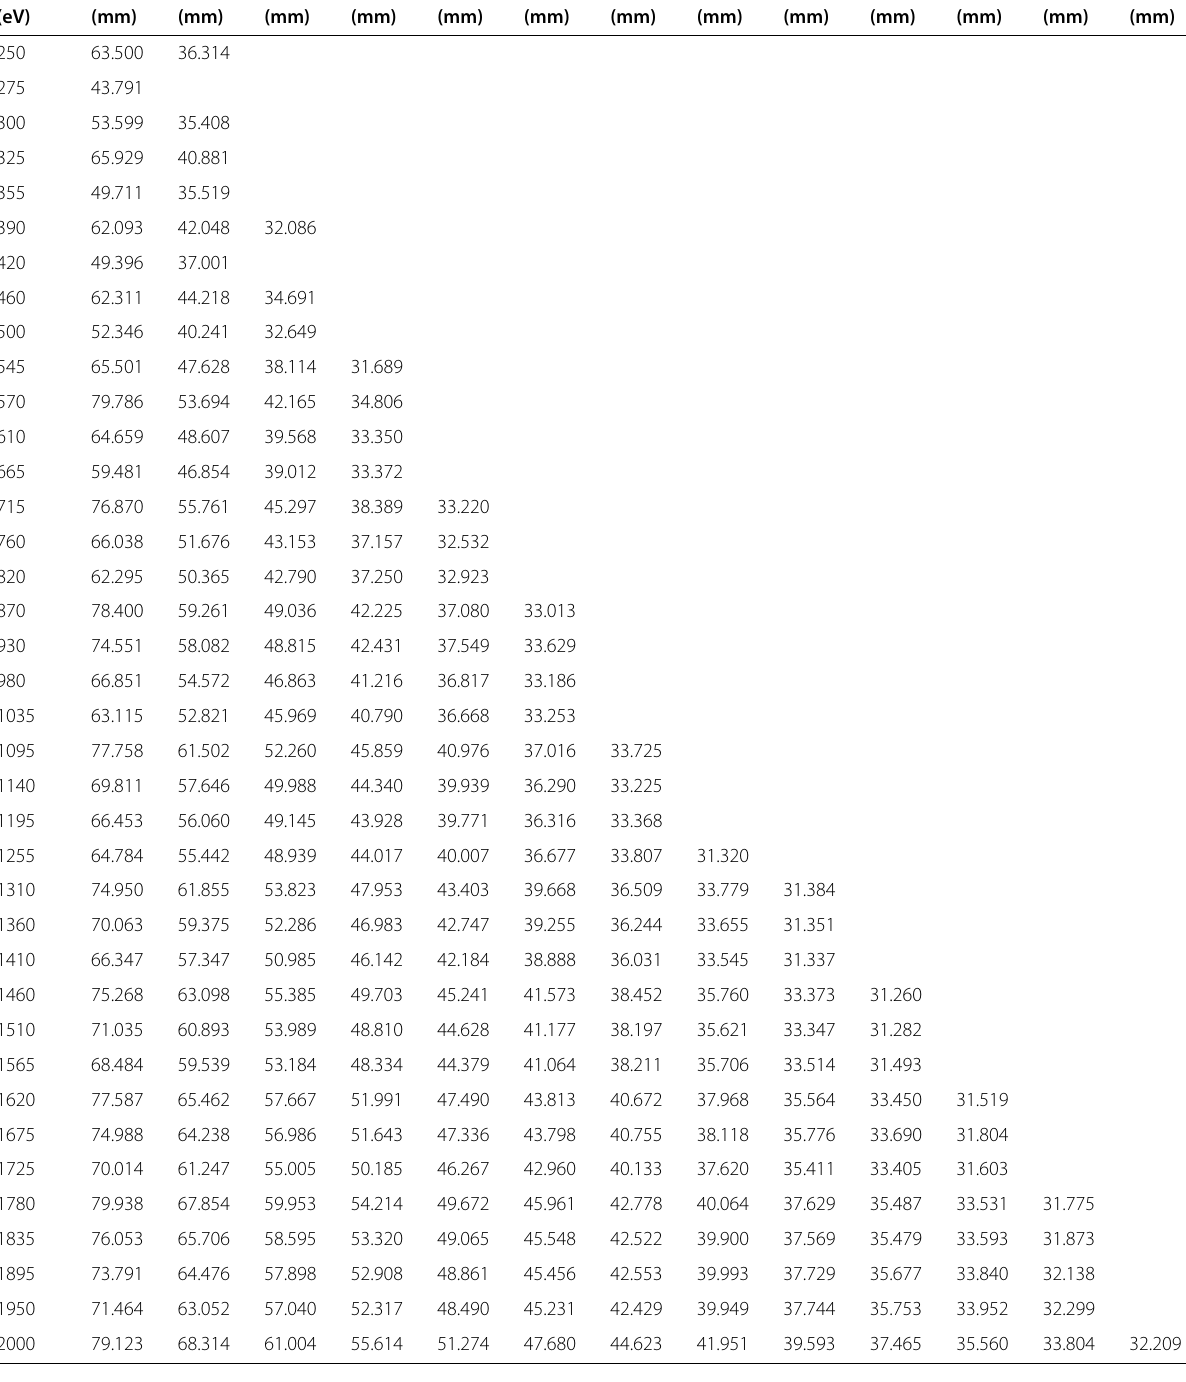
Table 5 Optimal gaps of PS1 at each energy determined by maximizing the flux from ID1 and ID3